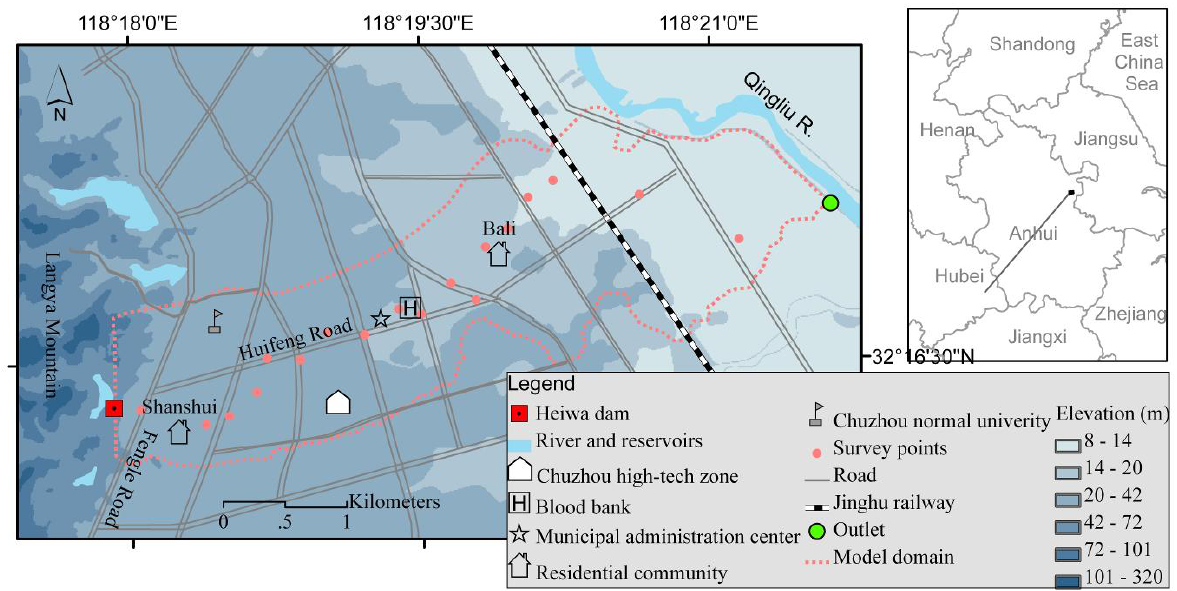
Figure 2. Study area and locations of important elements vulnerable to flood damage.